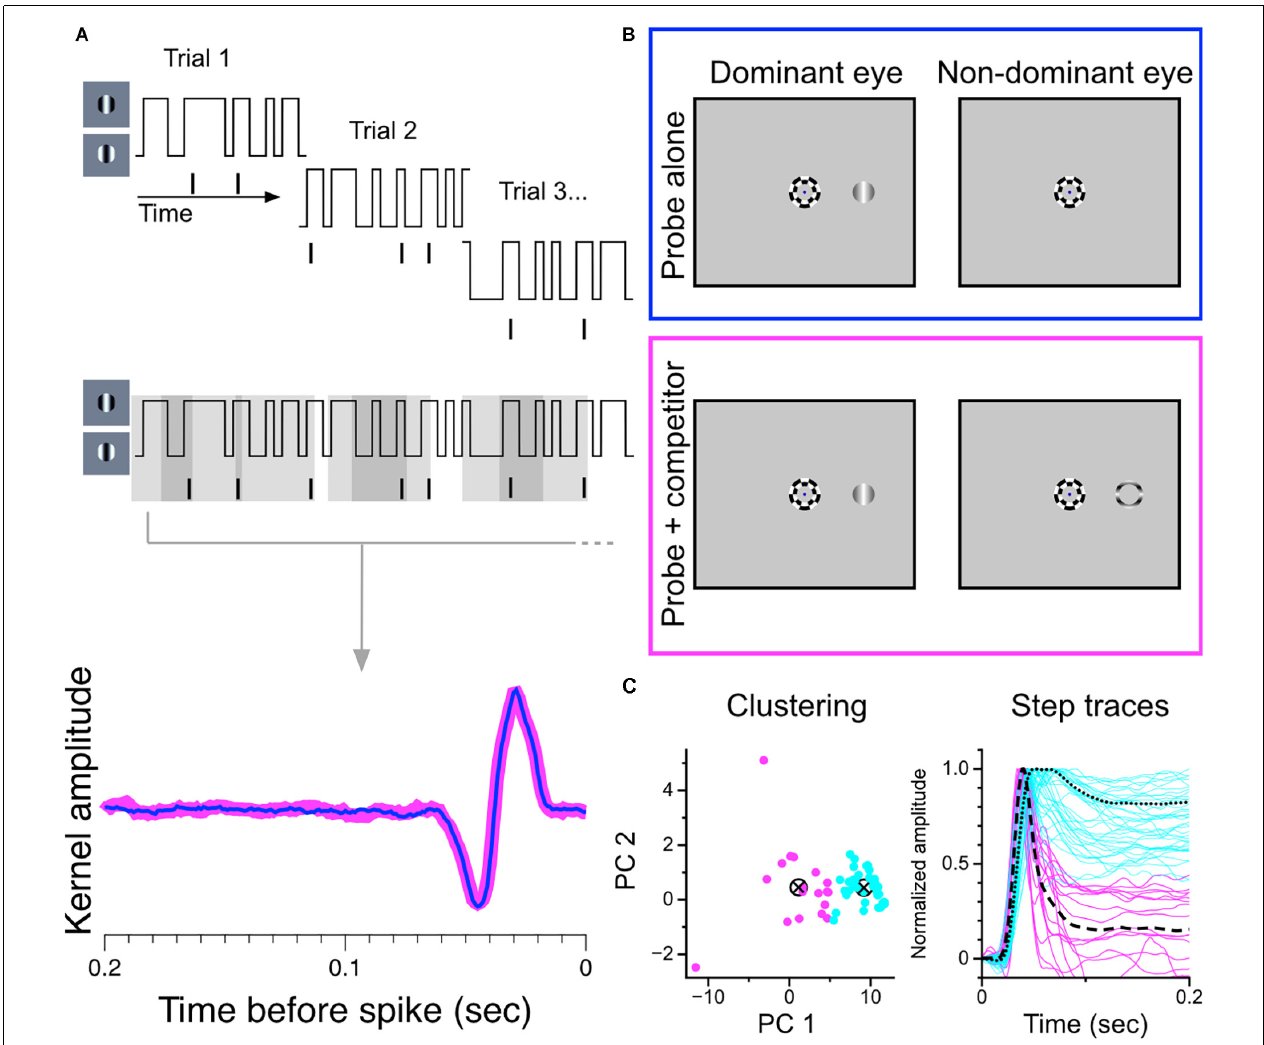
FIGURE 7 | Construction and partitioning of temporal kernels recovered during monocular stimulation and during binocular rivalry. (A) Construction of temporal kernels. A grating centered over a cell’s receptive field updates its phase every 10 ms according to a random binary noise sequence. Overlapping segments of the stimulus are presented in 2.1 s trials. Temporal kernels are generated from the combined stimulus-response set. (B) Stimulus configuration. Trials were randomly interleaved in which either the monocular probe grating was presented alone to the dominant eye or was presented simultaneously with a suppressor stimulus in the other eye to generate binocular rivalry. The full noise sequence was completed for both trial conditions. Suppressor could be a thin annulus (shown here) of an orthogonally-drifting grating, or a full drifting grating, orthogonal to probe. (C) Partitioning of temporal kernels. Normalized data were projected onto the first two principal components of the data matrix and clustered using k-means seeded with two centroids. Partitioned step responses (normalized) are shown at